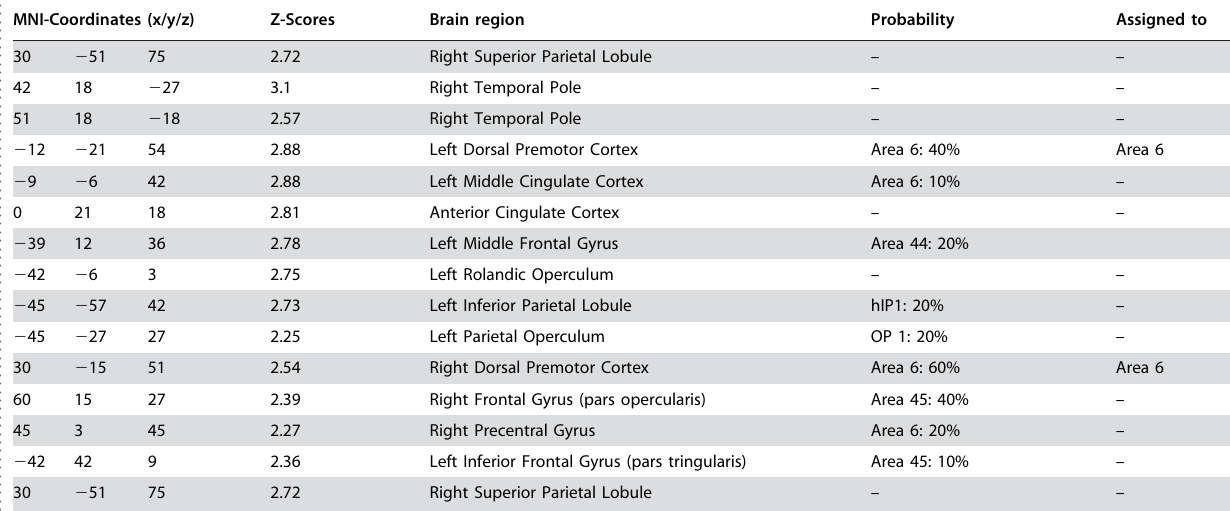
Table 4. Summary of peak locations of BOLD signal change negatively correlated to the number of learning trials the subjects needed before reaching the learning criteria (p , 0.05, K . 50, Z-scores . 2.25). .. ... .... ... ... .... ... ... .... ... ... .... ... ... .... ... ... .... ... ... .... ... ... .... ... ... .... ... ... .... ... ... .... ... ... .... ... ... .... ... ... .... ... ... . MNI-Coordinates (x/y/z) Z-Scores Brain region Probability Assigned to